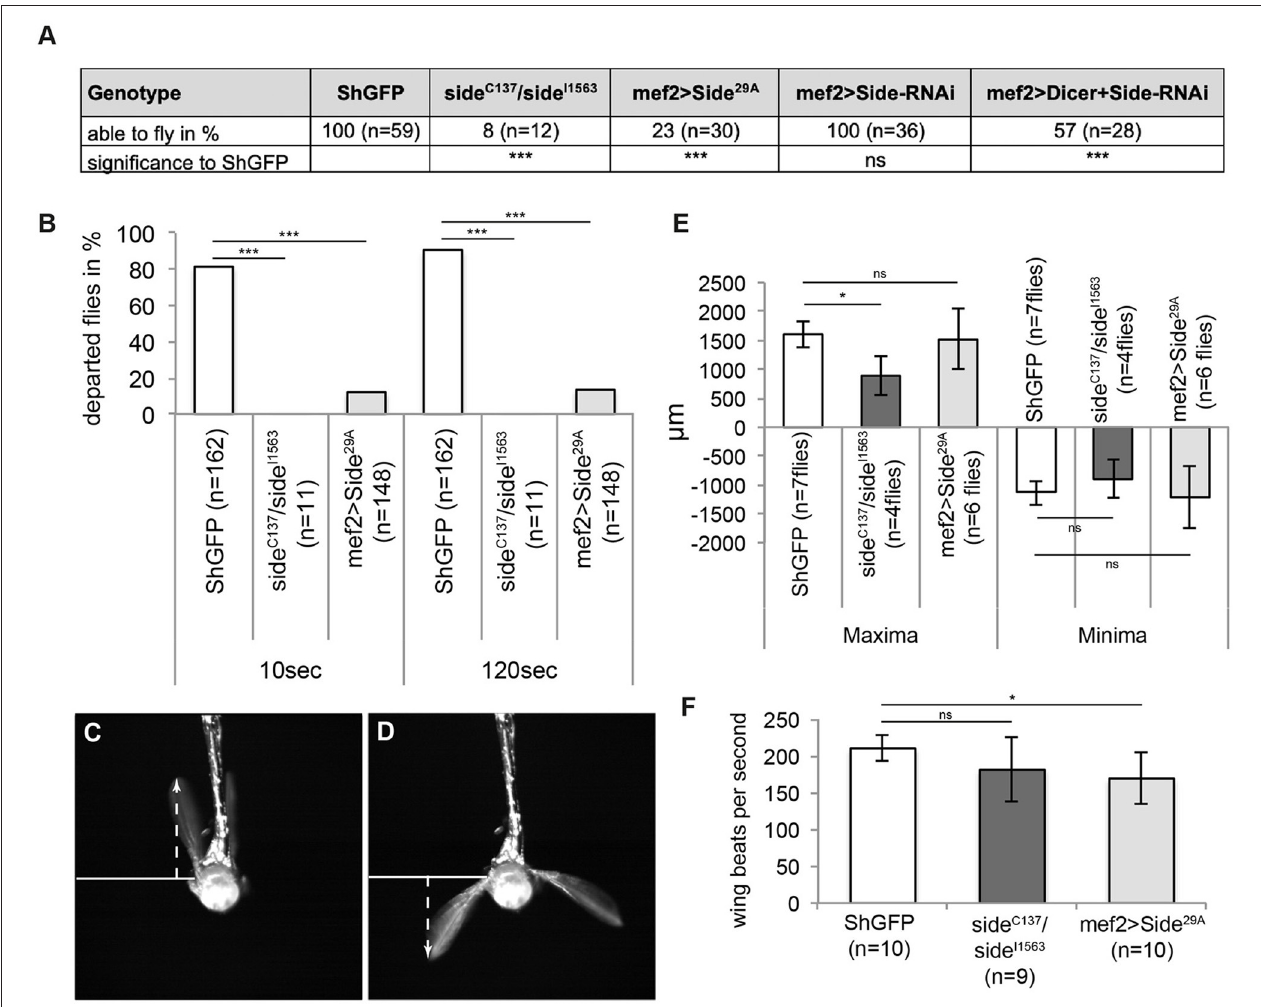
FIGURE 5 | Misinnervation of indirect flight muscles results in the inability to initiate free, unrestricted flight. (A) Side mutant and overexpressing Sides are not able to fly when tested in the dropping assay. Downregulation of Side by RNAi show also reduced fly capacities compared to controls but only when enhanced by Dicer. (B) Percentage of flies of the indicated genotypes that depart from a platform surrounded by water (island assay). Flies lacking side are unable to initiate free flight, even after 120s, whereas more than 20 and 90% of overexpressing Side and control flies, respectively, depart in the same time period. (C,D) Example images of high-speed video recordings during tethered flight of a ShGFP control fly. Arrows indicate the maximum and minimum distances from the wing hinge to the uppermost and lowermost turning points, respectively. (E,F) Statistical analysis of wing amplitude and wing beat. Wing amplitude is reduced in side mutants (E) , whereas overexpressing Side flies exhibit a reduced number of wing beats per second (F) . Data are total numbers in ( A,B , n = number of males, *** P < 0.001 Fisher exact test) and means ± SD. ( E,F , n = number of males, * P < 0.05, ns, not significant, one-way ANOVA). Genotypes: w; + ;ShGFP, w; + ;side C 137 , ShGFP/side I 1563 , ShGFP, w; + ;Mef2-Gal4, ShGFP/UAS-Side 29 A